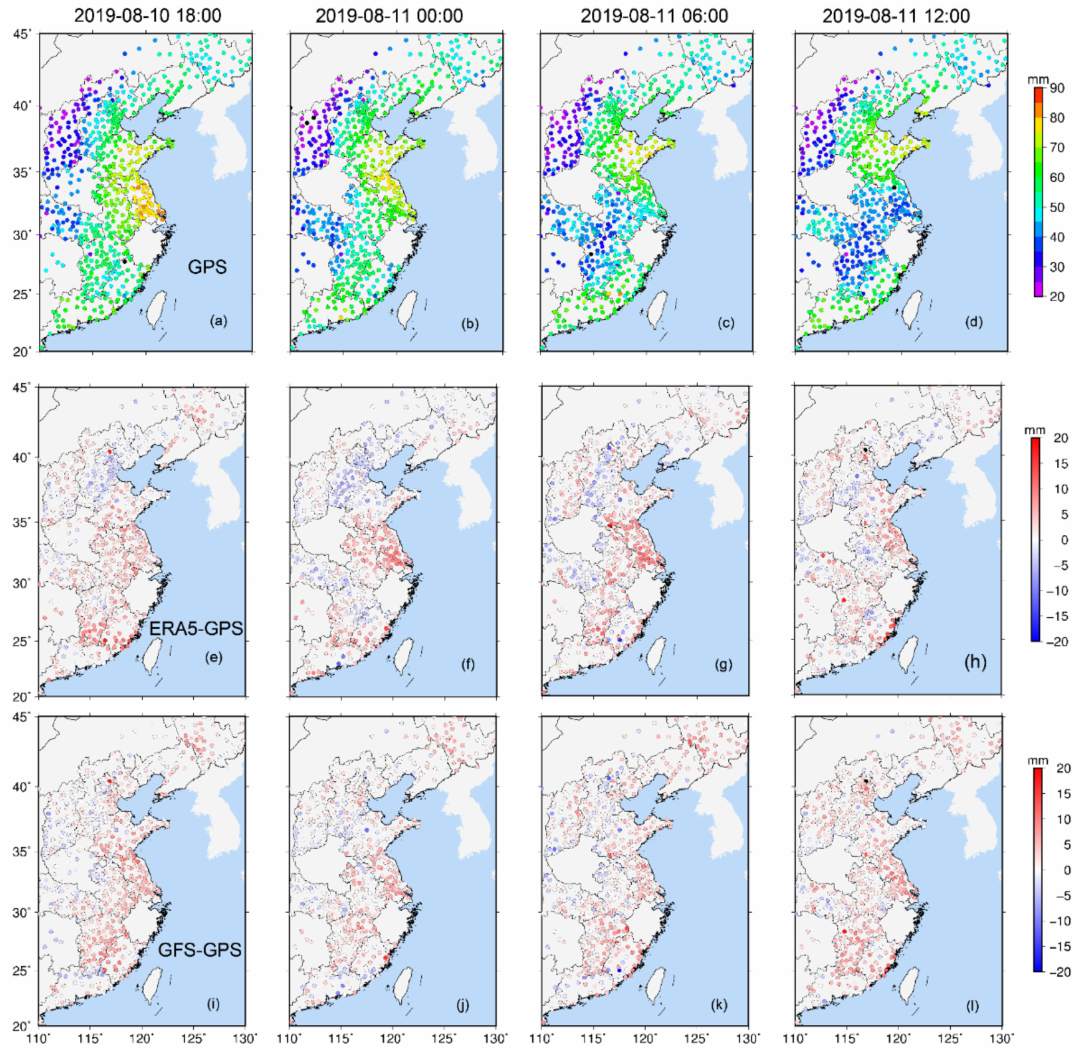
Figure 4. ( a – d ) PWV spatial distribution at UTC time 10 August 18:00, 11 August 00:00, 11 August 06:00 and 11 August 12:00, respectively; ( e – h ) PWV difference (ERA5 minus GPS) at the four epochs; ( i – l ) PWV difference (GFS minus GPS) at the four